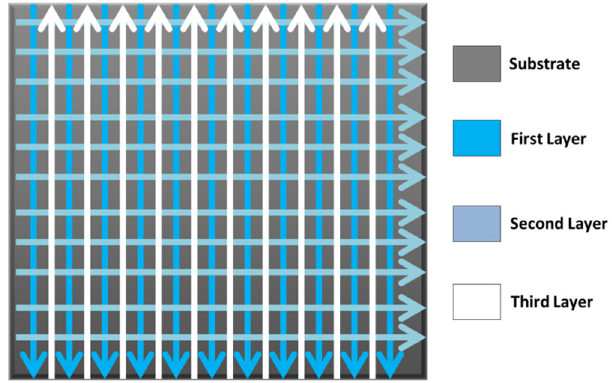
Figure 1. Schematic figure of the electrospark deposition method performed for the experiments.